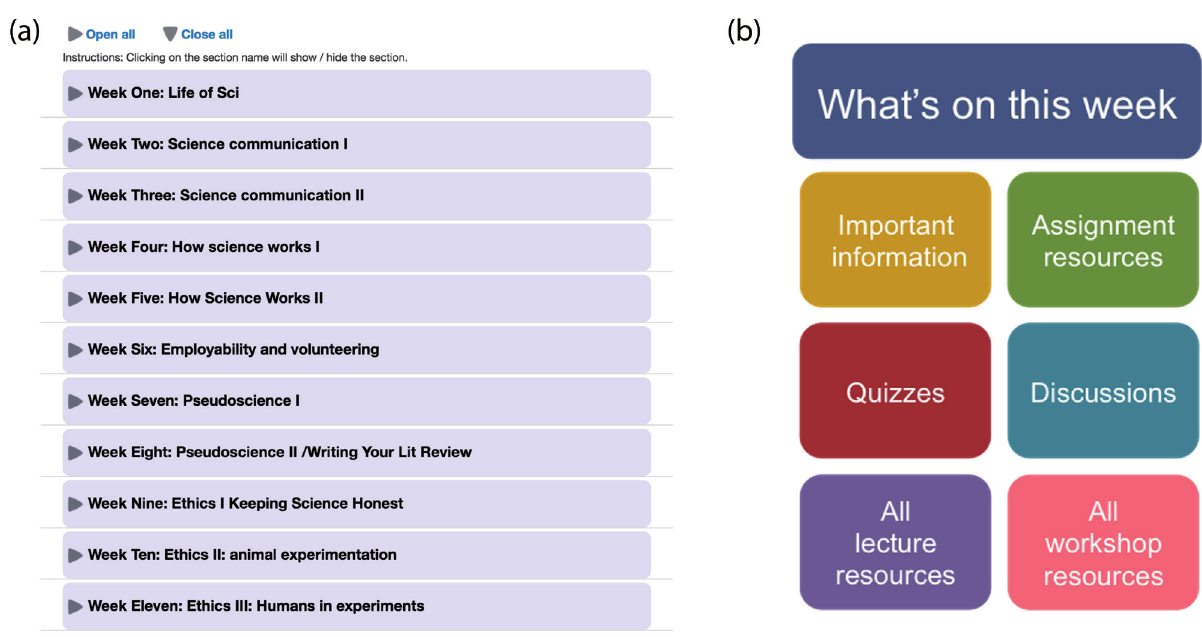
Figure 2. Landing page for students on the learning management systems. ( a ) Previous layout with week-by-week arrangement, typical of many courses; ( b ) Menu buttons and themes positioned on the front